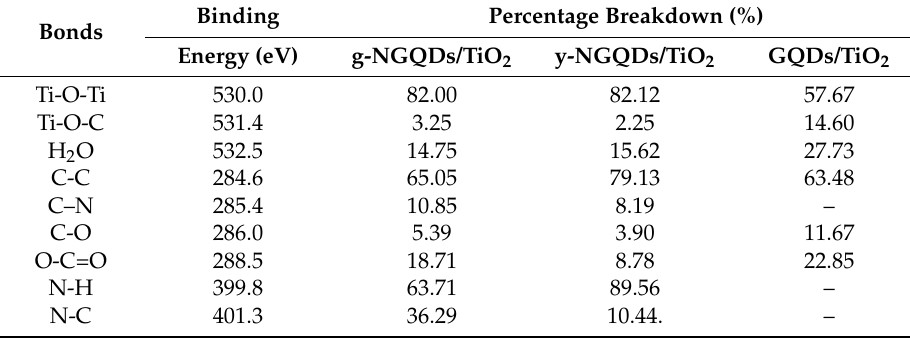
Table 1. Percentage breakdown of different bonds within the XPS (X-ray photoelectron spectroscopy) high-resolution spectra calculated from Figure